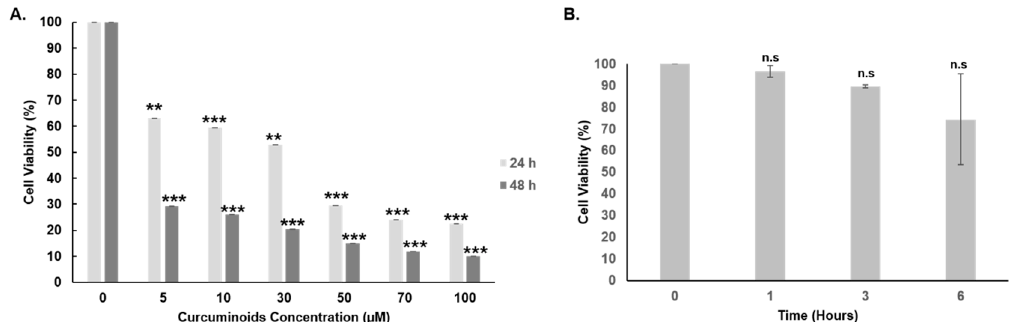
Figure 5. ( A ) Effects of various concentrations (5–100 µM) of curcuminoids on the viability of human SKOV-3 cells treated for 24 h and 48 h, as measured by WST-1 assay. ** and *** indicate statistical significance (p < 0.01 and p < 0.001, respectively) compared to the untreated cells. ( B ) The survival rate of SKOV-3 cells treated with 30 µM curcuminoid for 1 h, 3 h, and 6 h; n.s., no significant difference when compared to the untreated cells.